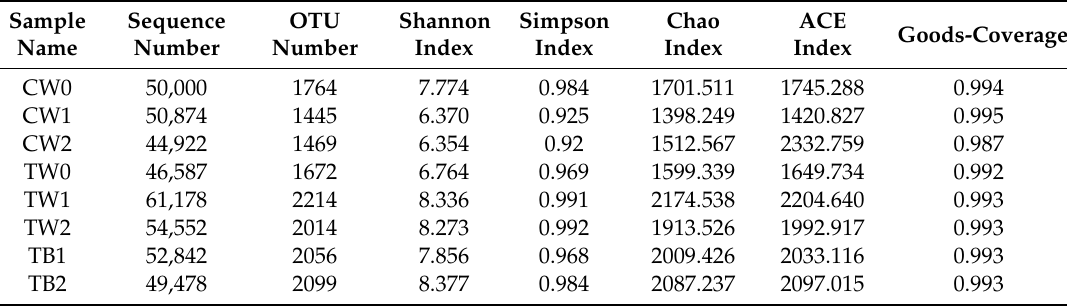
Table 1. Statistics for different treatment samples.